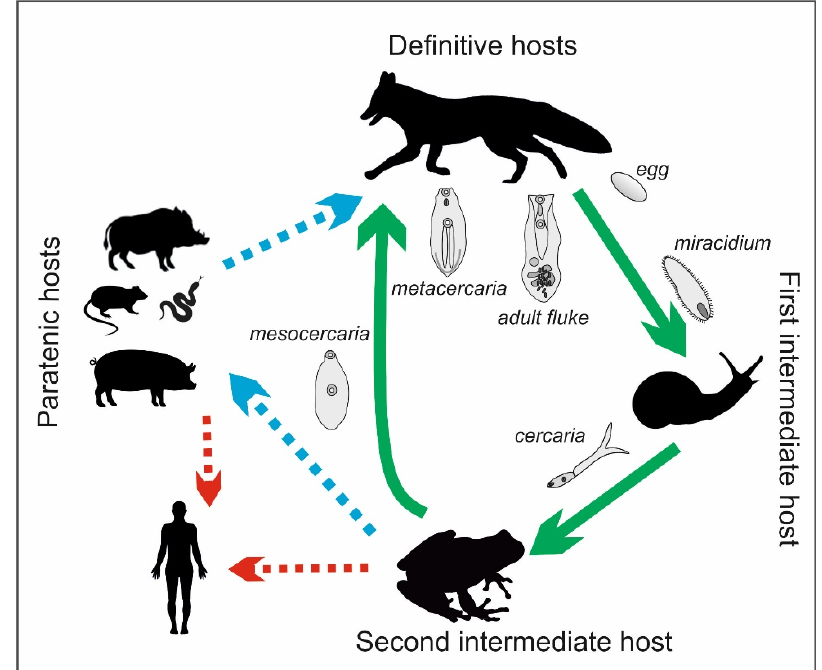
Figure 3. Life cycle of A. alata (by J. Karamon).